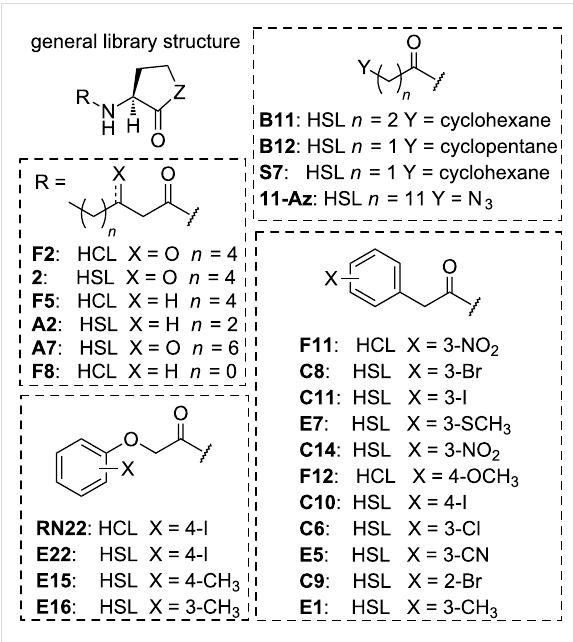
Figure 3: Chemical structures of the most potent SdiA agonists. Com- pound names (except for 11-Az ) match those reported in our prior publications. HSL = homoserine lactone, Z = O. HCL = homocysteine thiolactone, Z = S. Compound 2 = L-OOHL. Compounds within each cluster (indicated by hashed line box) are listed in order of highest to lowest potency.